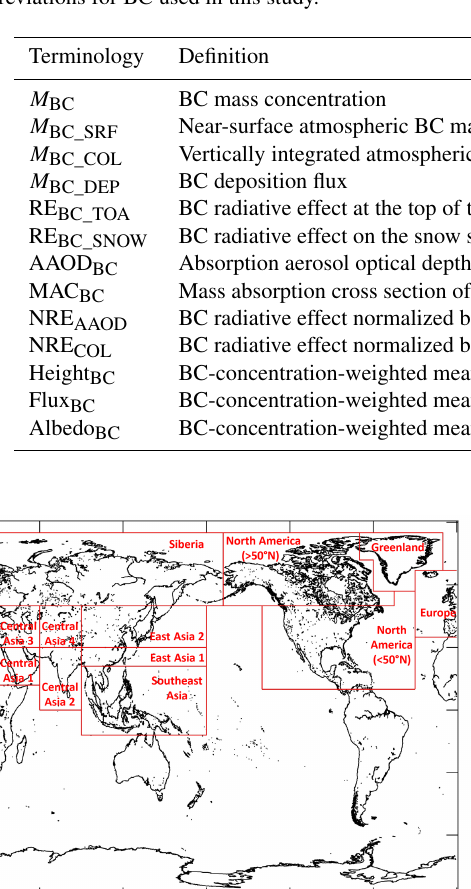
Table 1. Abbreviations for BC used in this study.